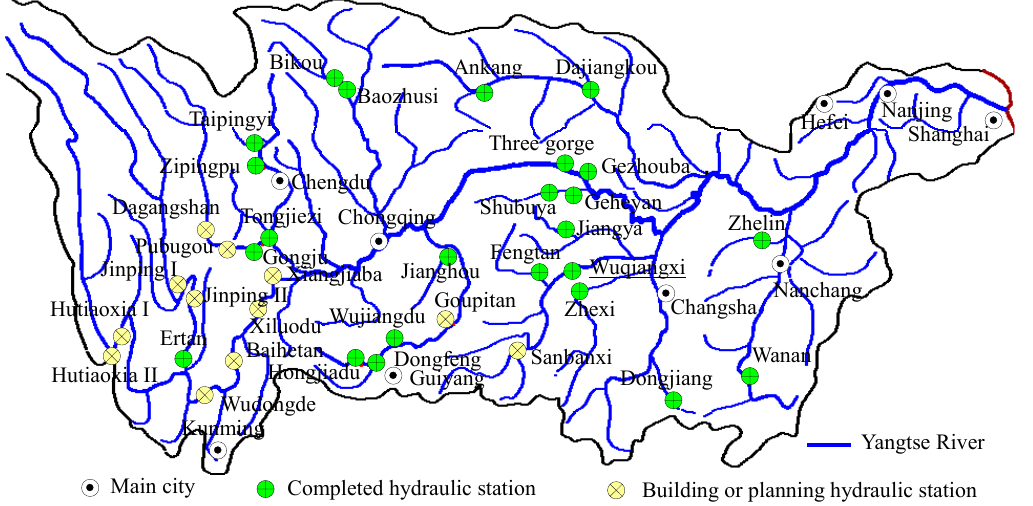
Figure 1. Main large or medium scale hydroelectric stations (under construction or planned) in Yangtse River region in